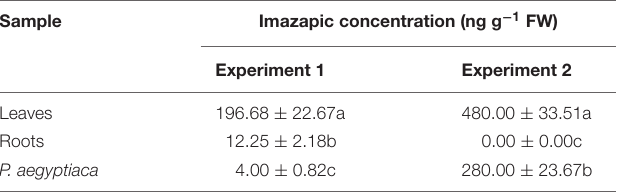
at a rate of 50 g a.i. ha − 1 .